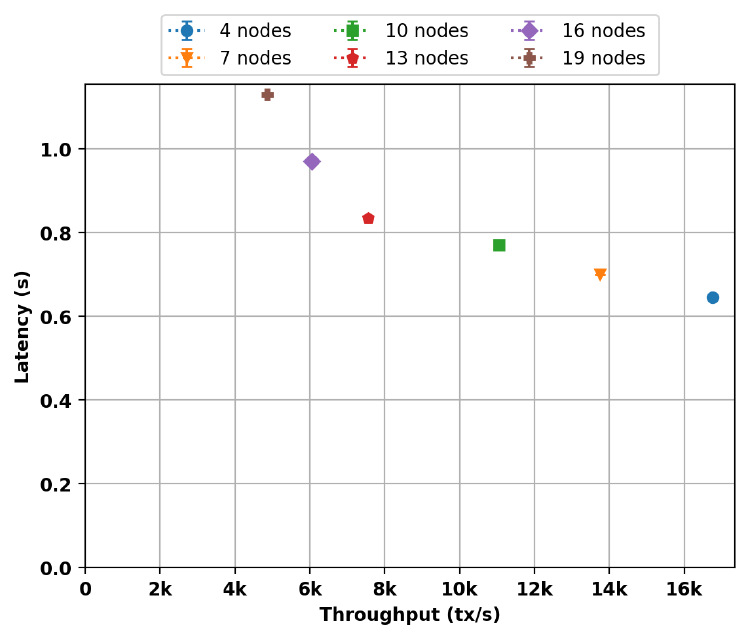
Figure 1. Latency and throughput of